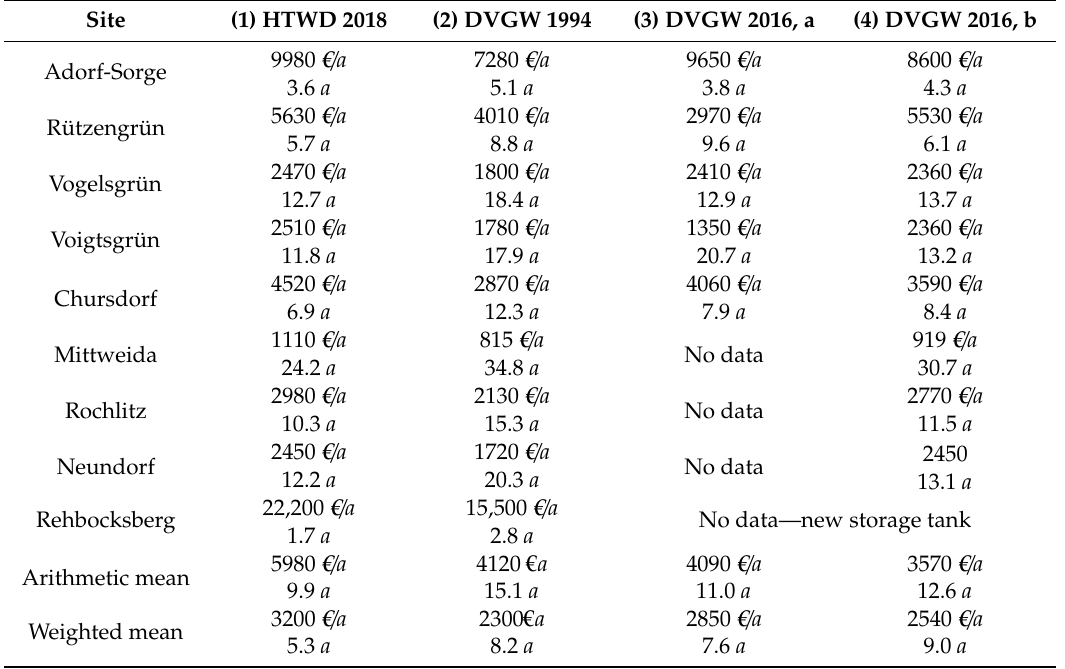
Table 7. Comparison of the estimated annual revenue (in € / a ) and simple payback period (in a ) for the turbine parameters determined using the four di ff erent turbine design